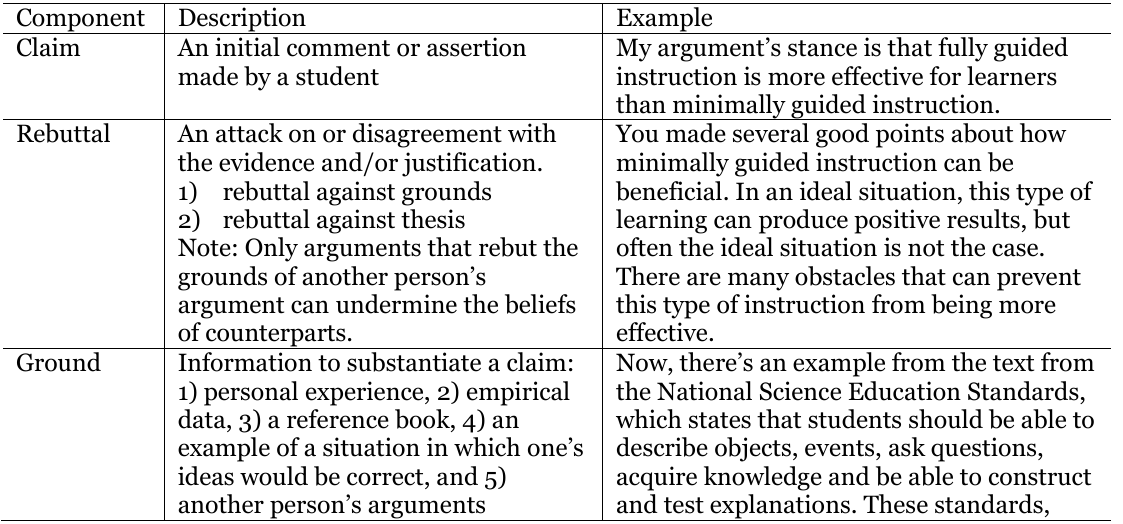
Description of the C omponents of an Argument and Example Postings